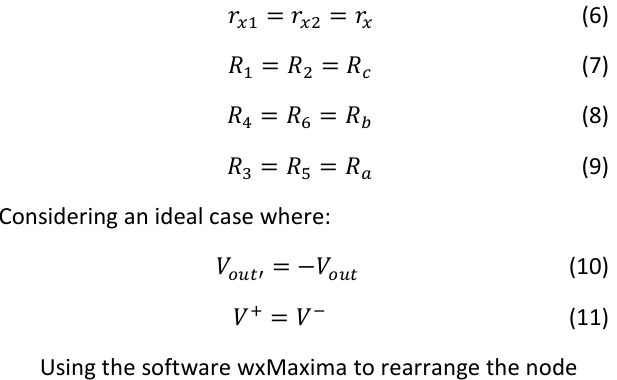
Fig.8: Crossed Differential Enhanced Howland Current Source with differential amplifiers